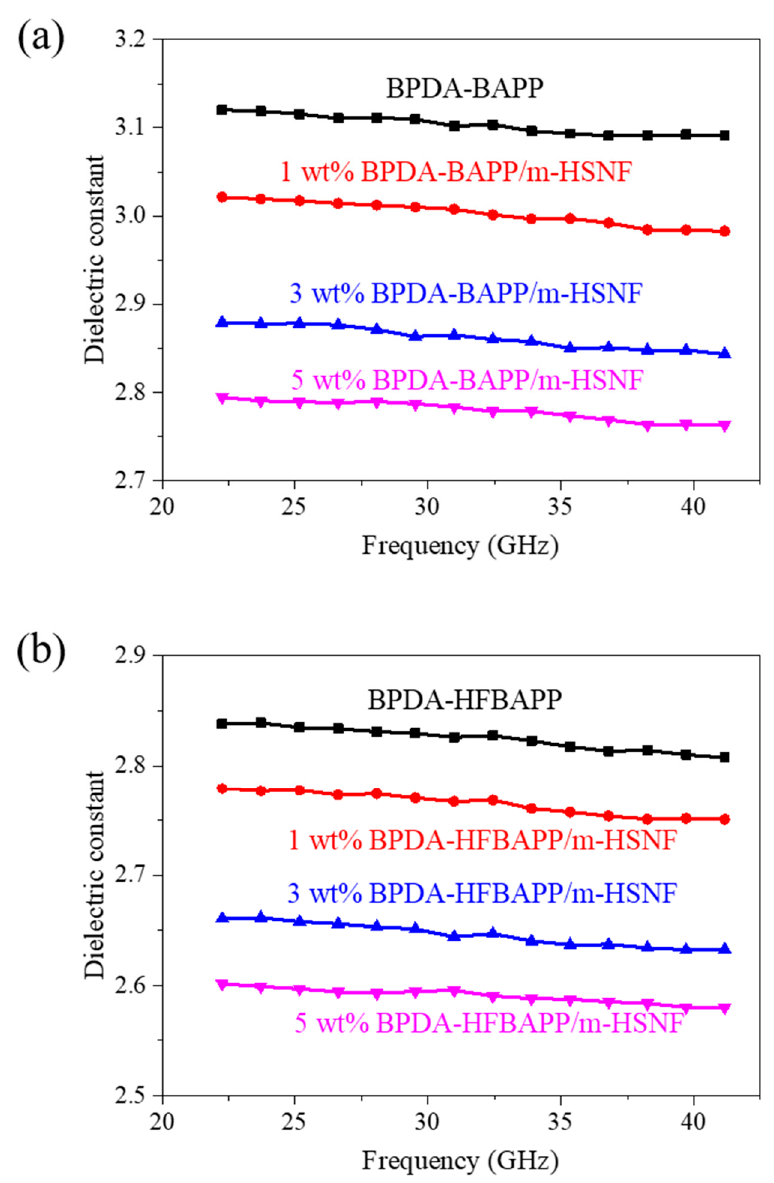
Figure 6. Dielectric properties of ( a ) BPDA-BAPP/m-HSNF and ( b ) BPDA-HFBAPP/m-HSNF nanocomposites.